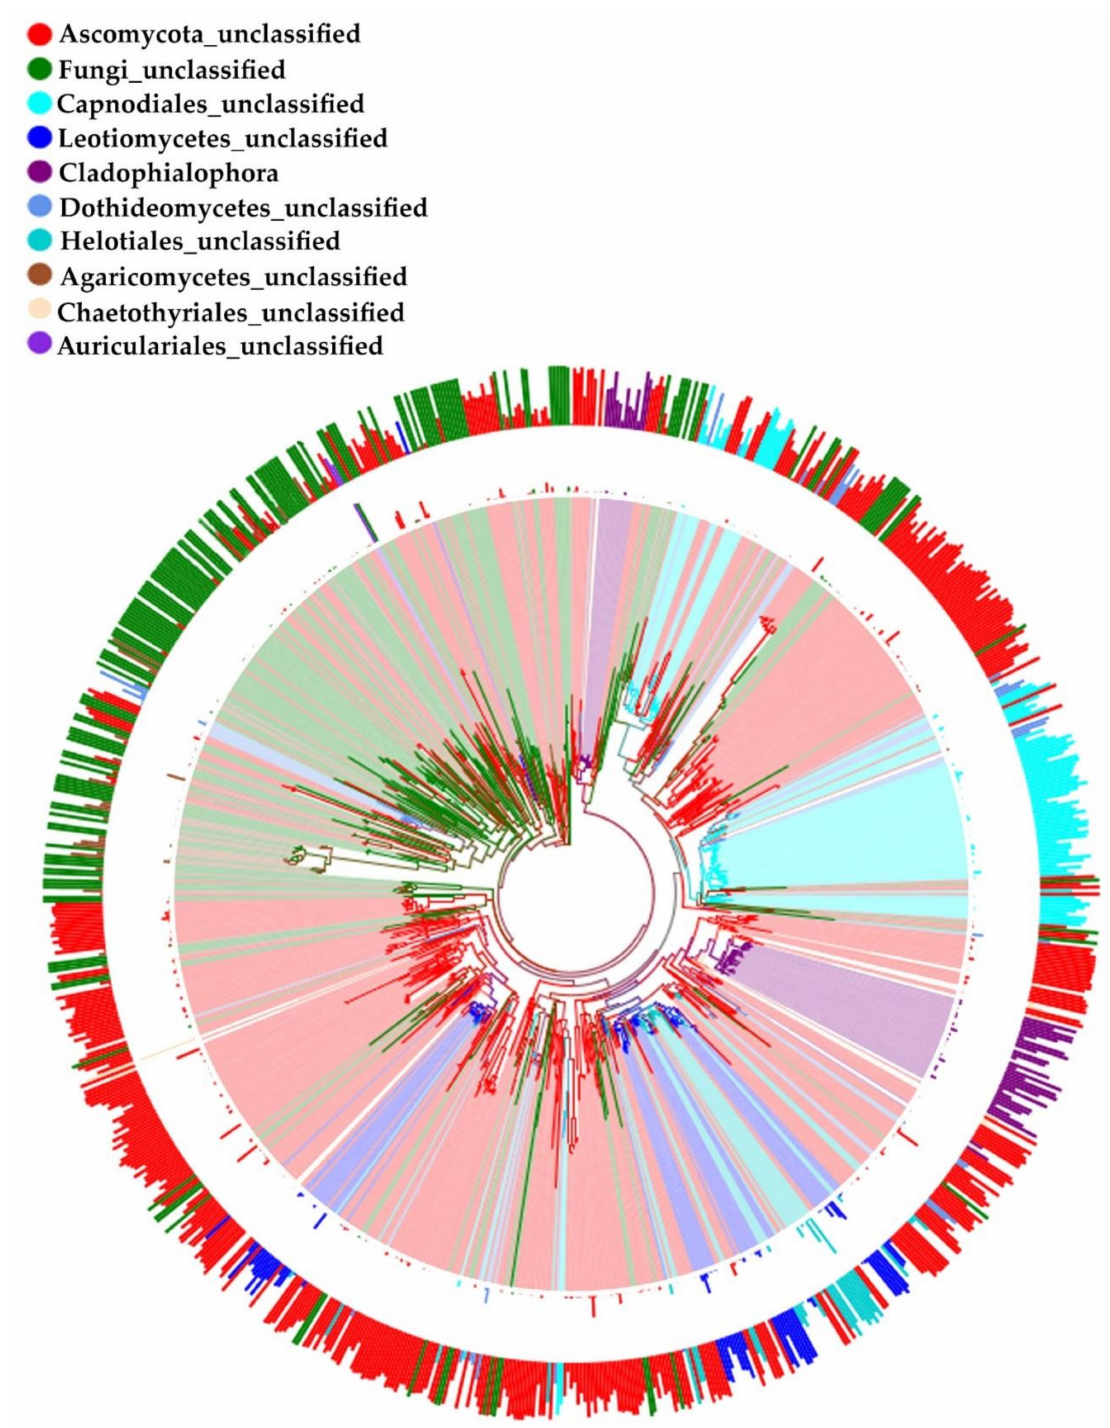
Figure 1. The phylogenetic tree and annotations of species that belong to the 10 genera with the highest abundance. From inside to outside: the first ring displays the neighbor-joining phylogenetic tree based on the internal transcribed spacer (ITS) rDNA alignment of all the OTUs belonging to the 10 operational taxonomic units (OTUs) ranked in different colors. Clade credibility values are indicated at internodes (bootstrap values 1000 replications). Each color represents a genus. The second ring is a representation of the relative abundance values; the value was converted according to the minimum and visualized. The third ring shows the reliability of the species identification, and the height of the columns shows the